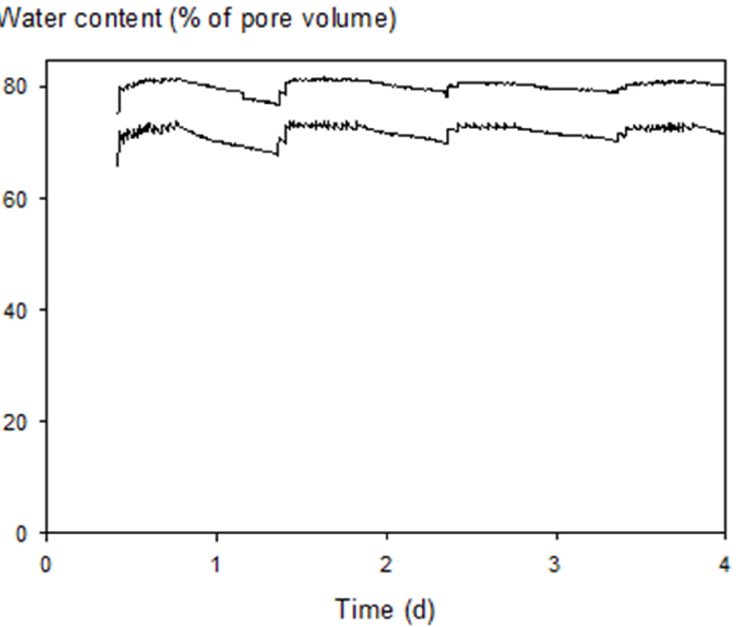
Figure 5. Water content (as % of pore volume) in the stone wool as a function of time as measured with duplicate sensors in two stone wool slabs. Time zero is 00.00 h 31 May.